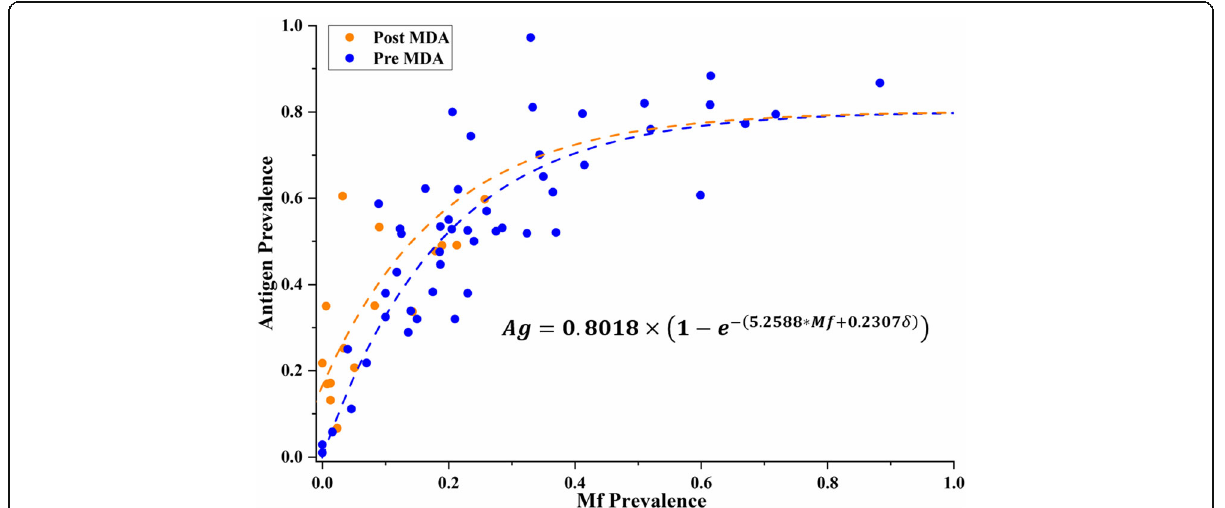
Fig. 3 Relationship between antigen and Mf prevalence predicted by model B1. This model suggests a “ converging ” predictive relationship between diagnostic tests as Mf prevalence increases